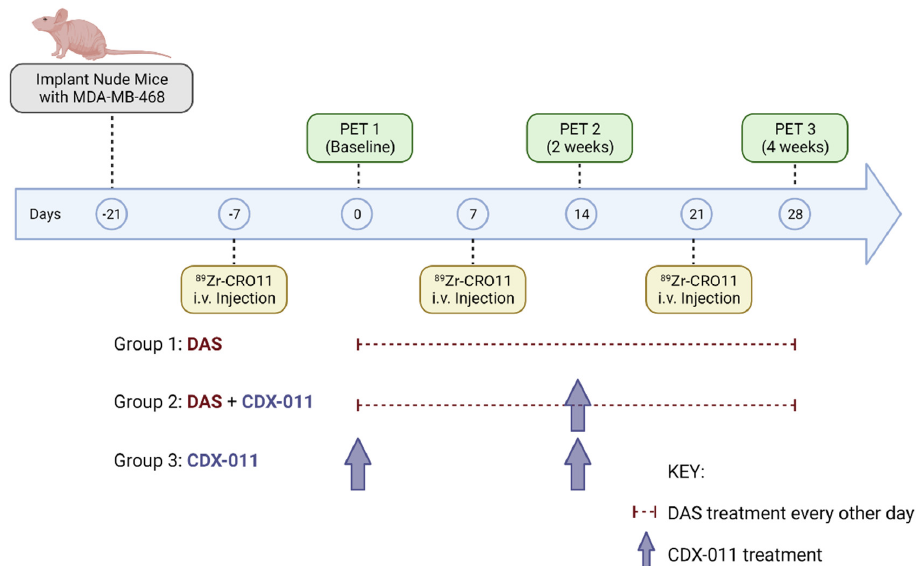
Figure 1. PET imaging and treatment paradigm in MDA-MB-468 xenografted mice. PET imaging with [89Zr]Zr-DFO-CR011 was performed at baseline, 14 days, and 28 days after treatment with dasatinib, CDX-011, or a combination of dasatinib and CDX-011 to monitor changes in gpNMB expression in vivo. DAS = dasatinib. A subgroup of mice (n = 4 out of 8 total) in each treatment arm underwent both PET imaging and therapy, while remaining mice only underwent therapy.